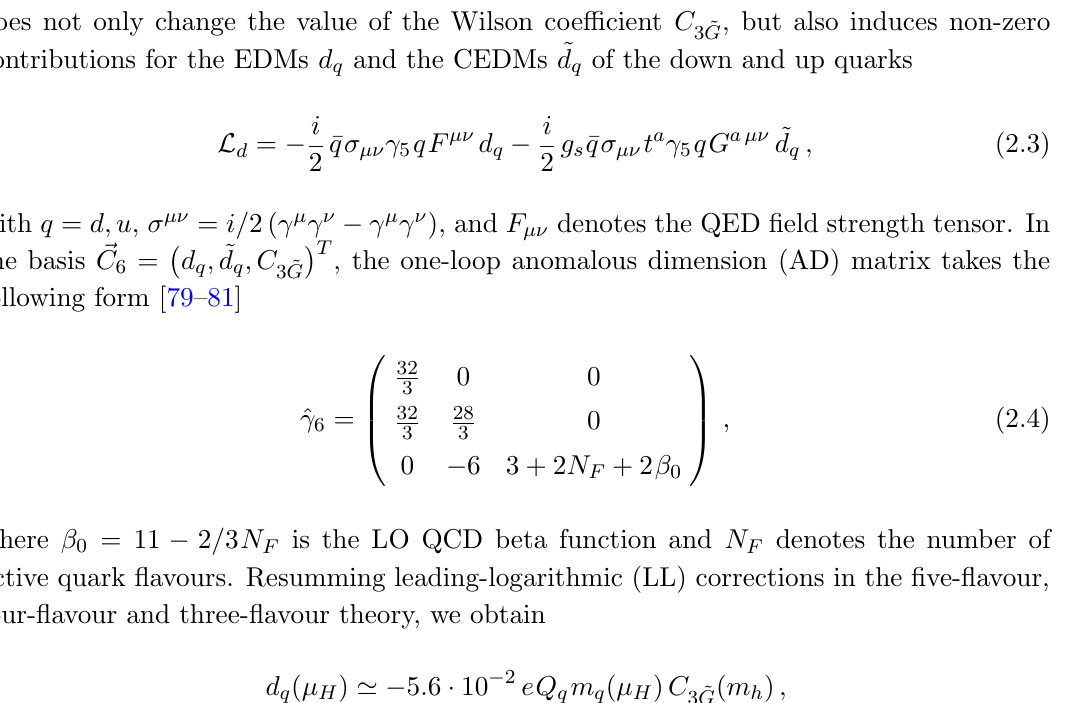
Figure 2 . Left: example diagrams of two-loop corrections to C Right: a one-loop correction to C are indicated by black